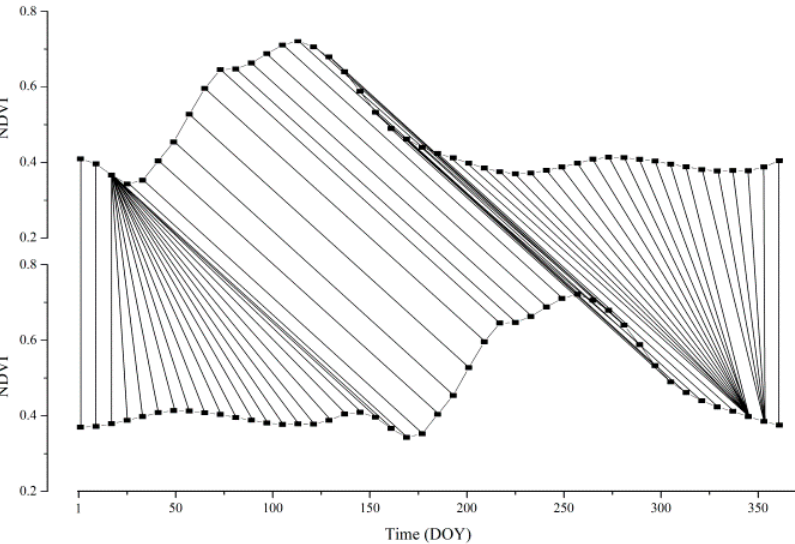
Figure 1. Warping path of two curves yielded by the open-boundary dynamic time warping method. The two curves’ growth seasons are staggered, but they are the same crop type. The open-boundary dynamic time warping (DTW) method is able to align these two curves’ growing season sections.